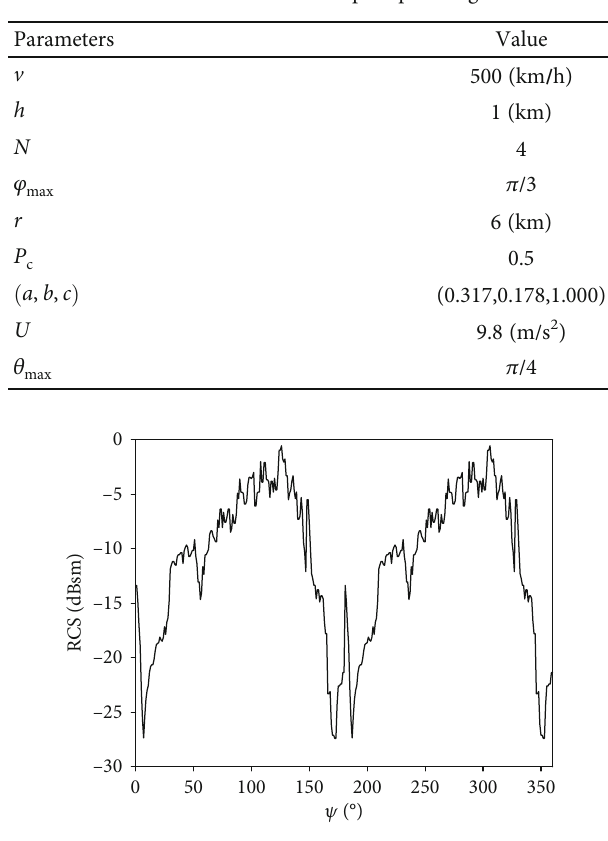
Figure 4: The RCS data of a certain type of stealth UAV. Table 2: The geographical location and types of threat sources in the fi rst threat